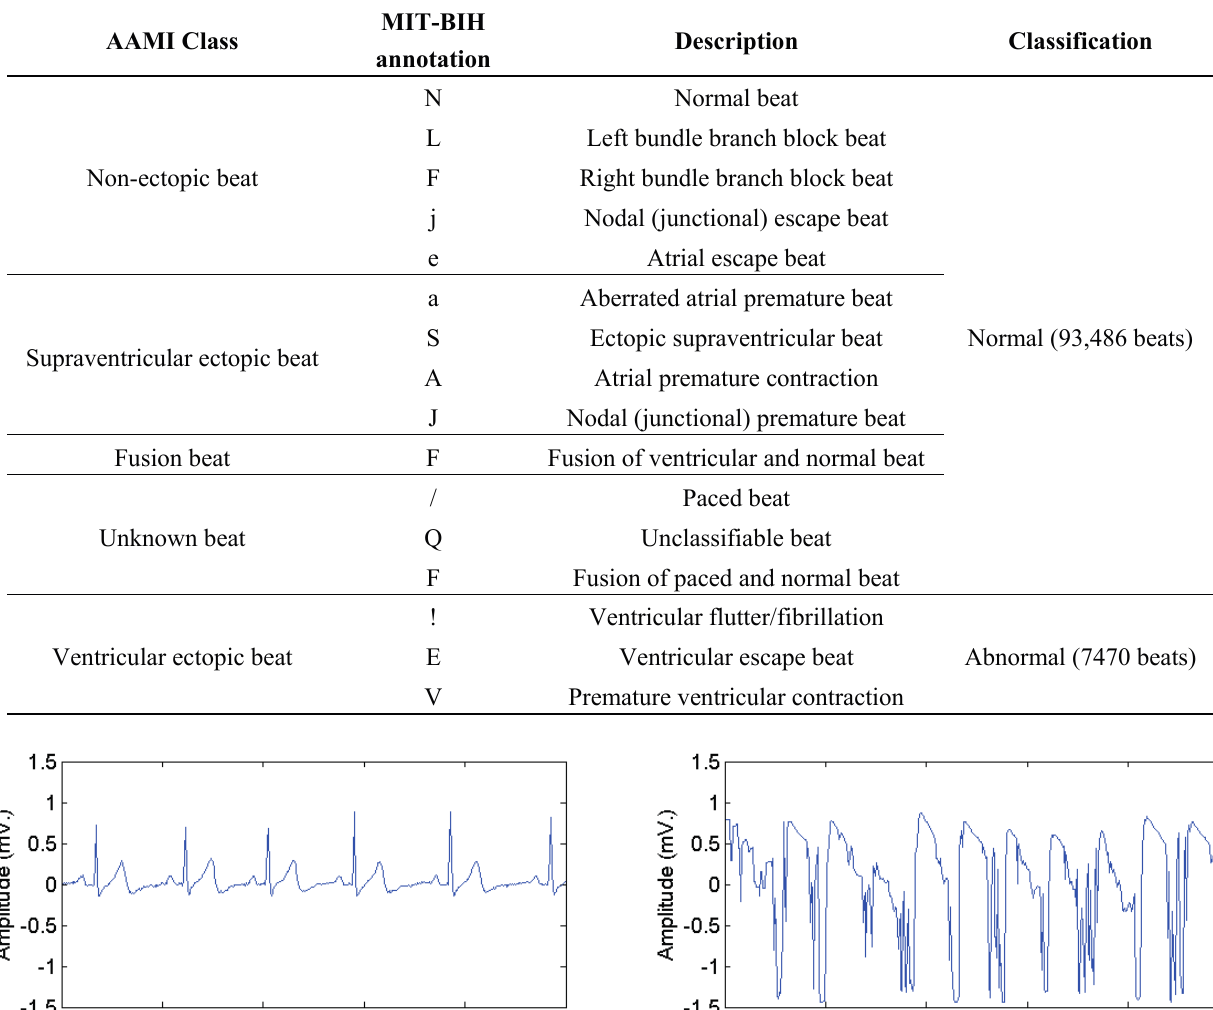
Table 5. Heartbeat types associated with beats in DS1.